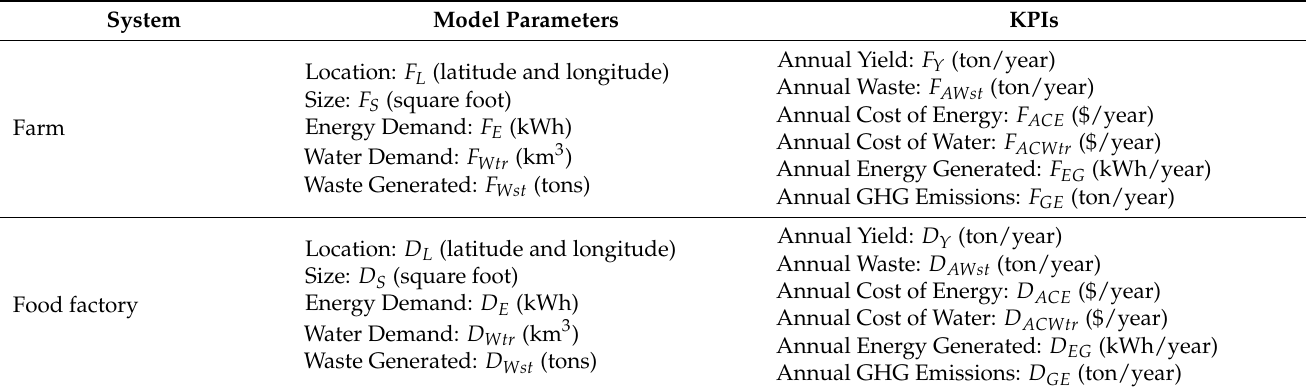
Table 1. Model parameters and key performance indicators of the case study interconnected systems.